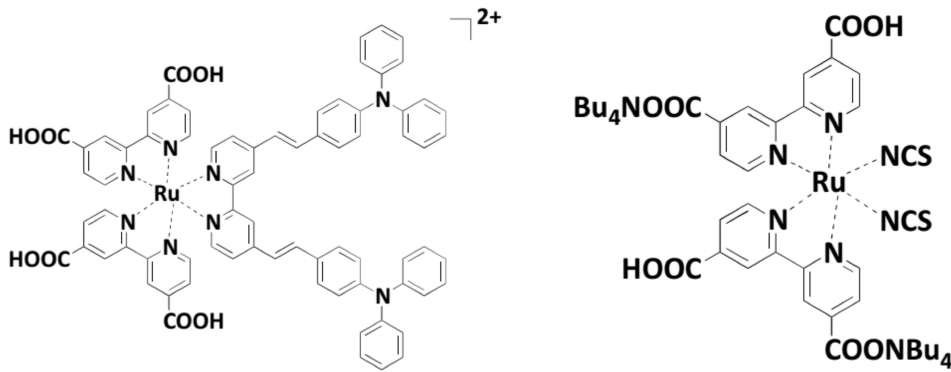
Figure 17. Bipyridyruthenium(II) complexes found in an Au NP via an amino or isothiocyanates group. Duplicates with reference agreement [143], ACS, 2005.